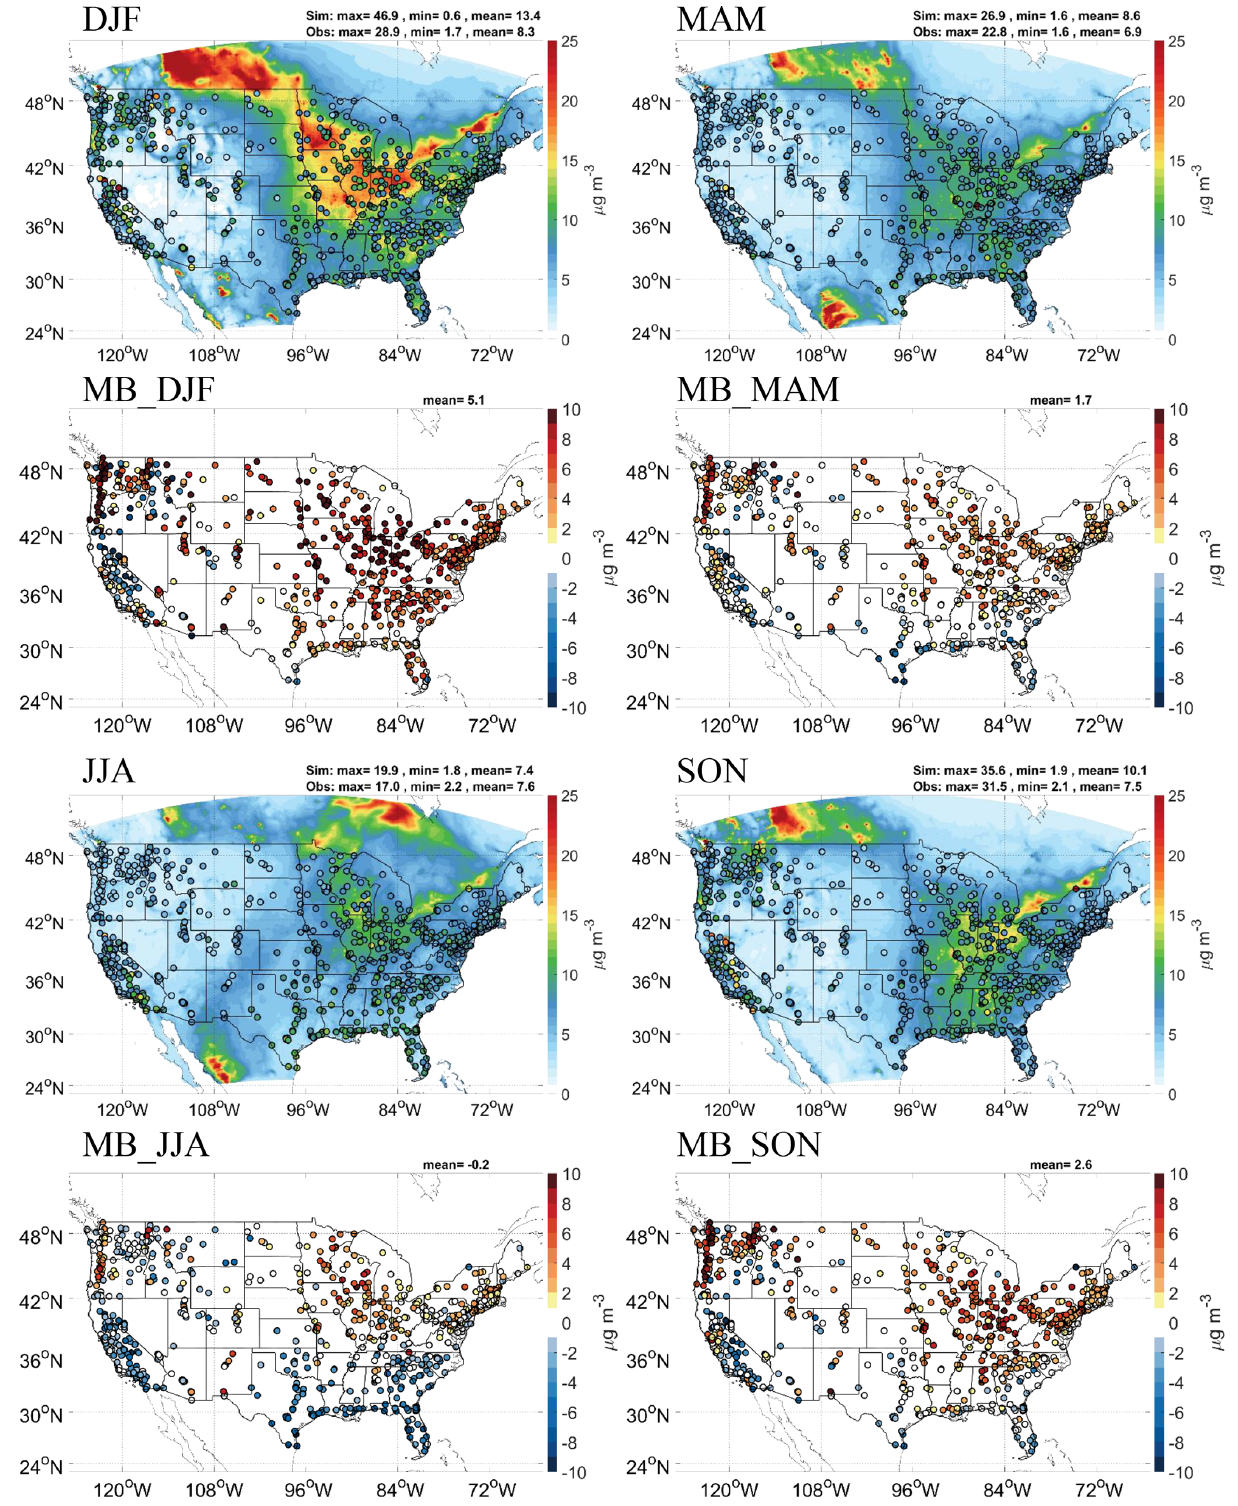
Figure 3. Forecasted seasonal daily PM 2 . 5 by GFSv15–CMAQv5.0.2 overlaid observations from AIRNow and MB compared to observations from